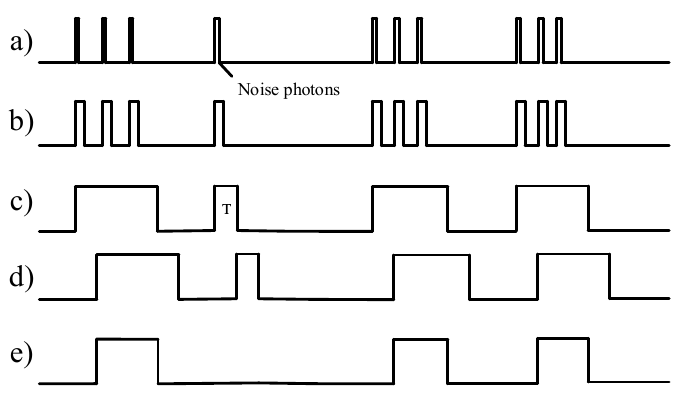
Figure 4. Timing of signal extraction: ( a ) single-photon pulse signal output by the detector; ( b ) stretched single-photon pulse signal; ( c ) trailing demodulated signal; ( d ) shift register output signal; and ( e ) demodulated signal.